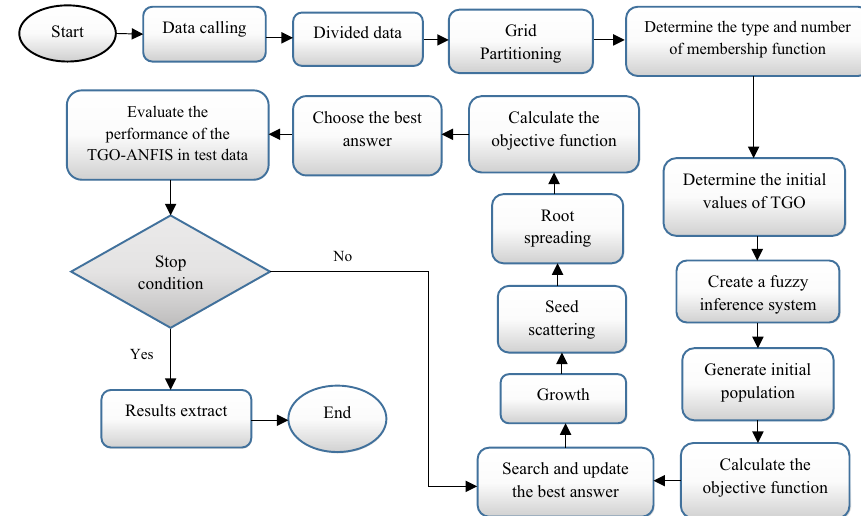
Fig. 5 Flowchart of TGO-